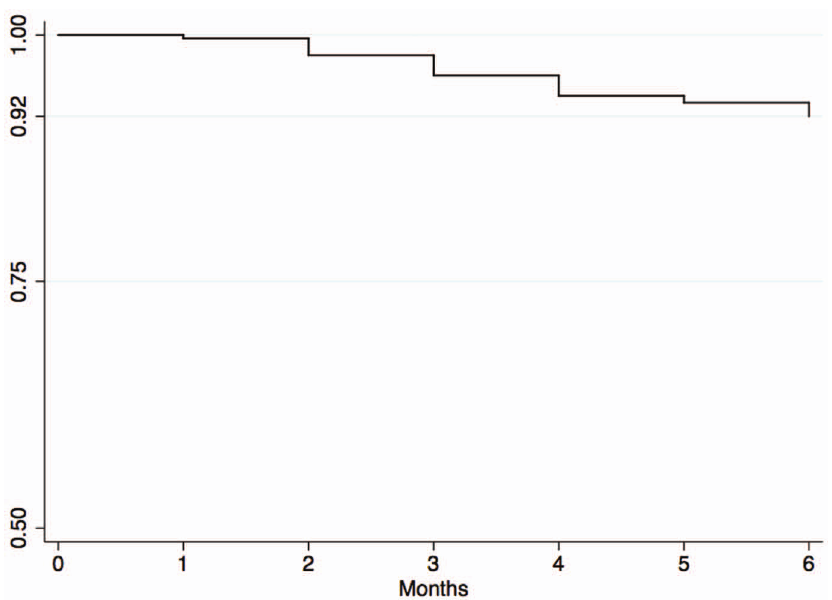
Figure 1. Survival Kaplan-Meier curve for Negative Outcomes of TB treatment.